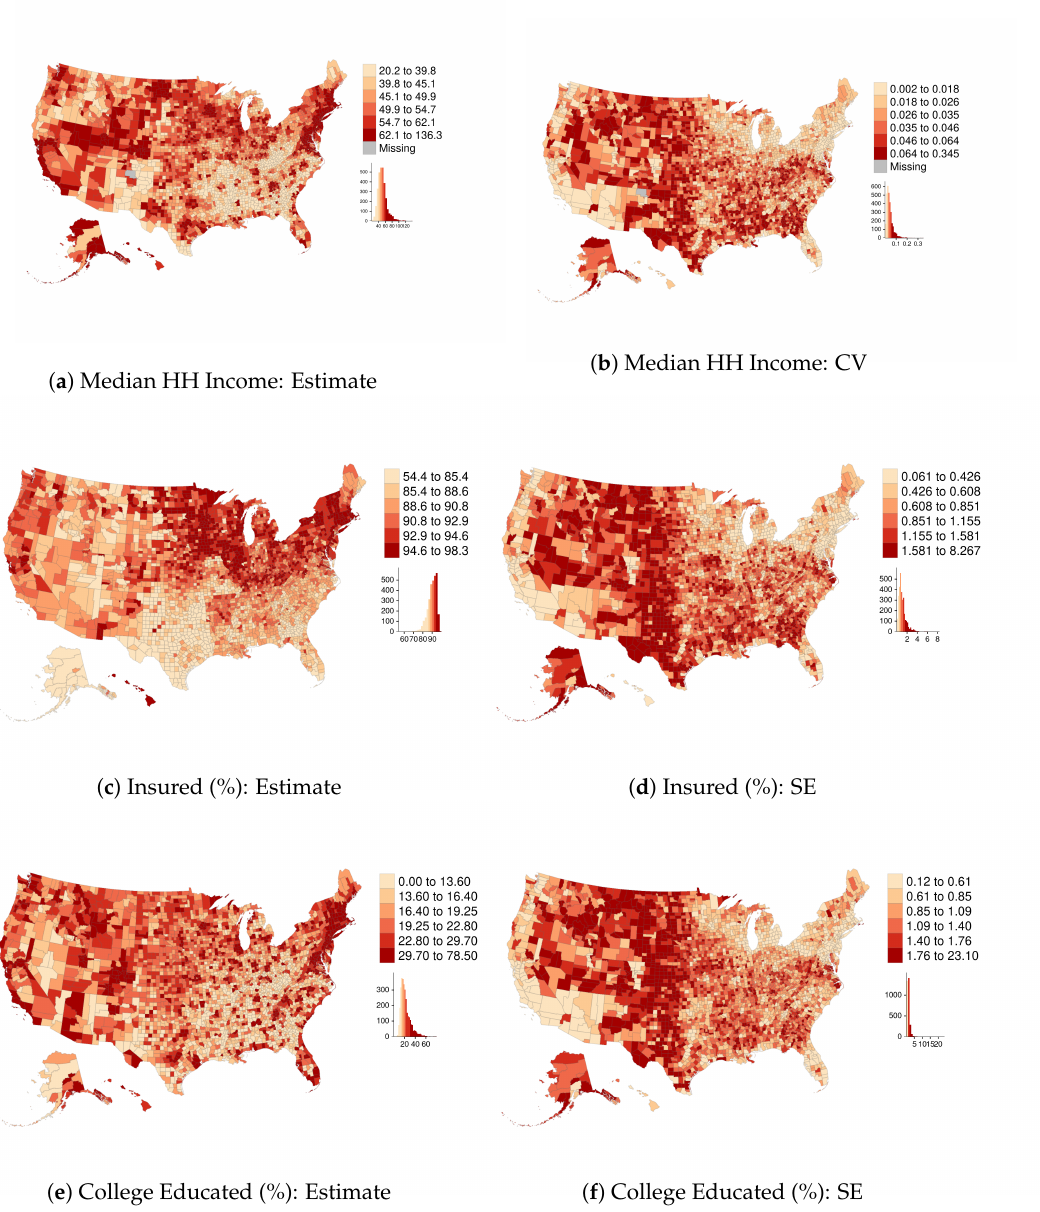
Figure 1. County-level five-year 206 ACS estimates and their data quality measures (CV for income, SEs for the others) for select variables. Median HH income is reported in thousands of